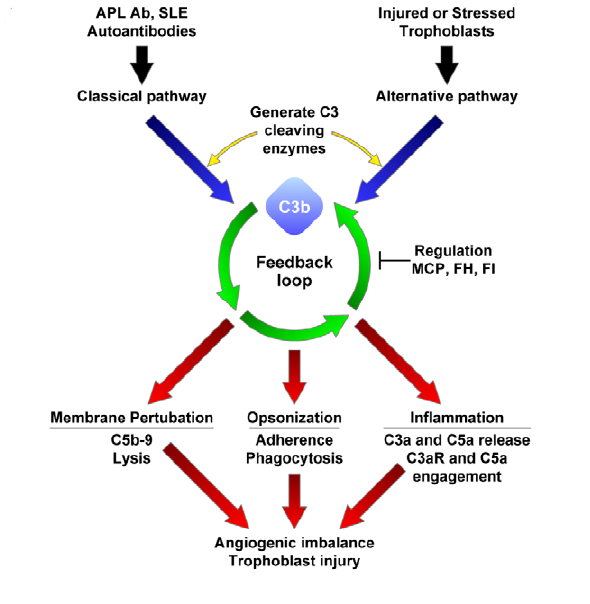
Figure 1. Complement activation in preeclampsia. Black and blue arrows indicate triggering of complement cascades by autoantibodies or damaged self-tissue; green arrows, deposition of C3b on a target sets in motion the powerful amplification loop of the alternative pathway; red arrows, effector activities of complement are generated by C3b deposition and C3a release and the downstream mediators C5b-9 and C5a. Regulation of feedback loop of alternative pathway on the placental trophoblasts (or endothelial cells) occurs through limited proteolytic cleavage of C3b to generate iC3b. This reaction is carried out by a serine protease, factor I (FI), along with membrane cofactor protein (MCP) or CFH (FH). Because SLE and APS are characterized by autoantibodies that trigger the classical pathway, defective regulation of C4b (a component of the classical pathway C3 convertase) by MCP is also likely to influence the severity of tissue injury and risk for preeclampsia. If regulators such as MCP, CFI (FI), or CFH (FH) are dysfunctional, excessive complement activation occurs. This may result in placental damage, thrombobosis and release of antiangiogenic factors, culminating in